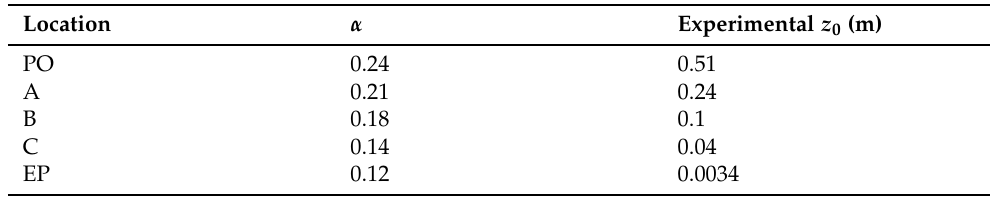
Table 1. Mean velocity of generic profile at selected locations according to power and logarith- mic